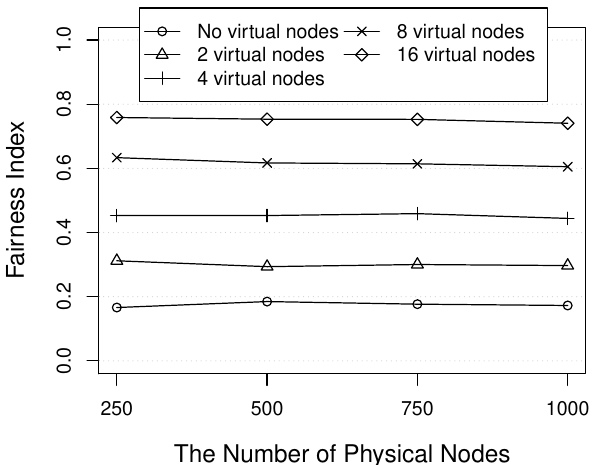
Figure 10. The fairness index of the number of the assigned data among physical nodes (Gaussian).